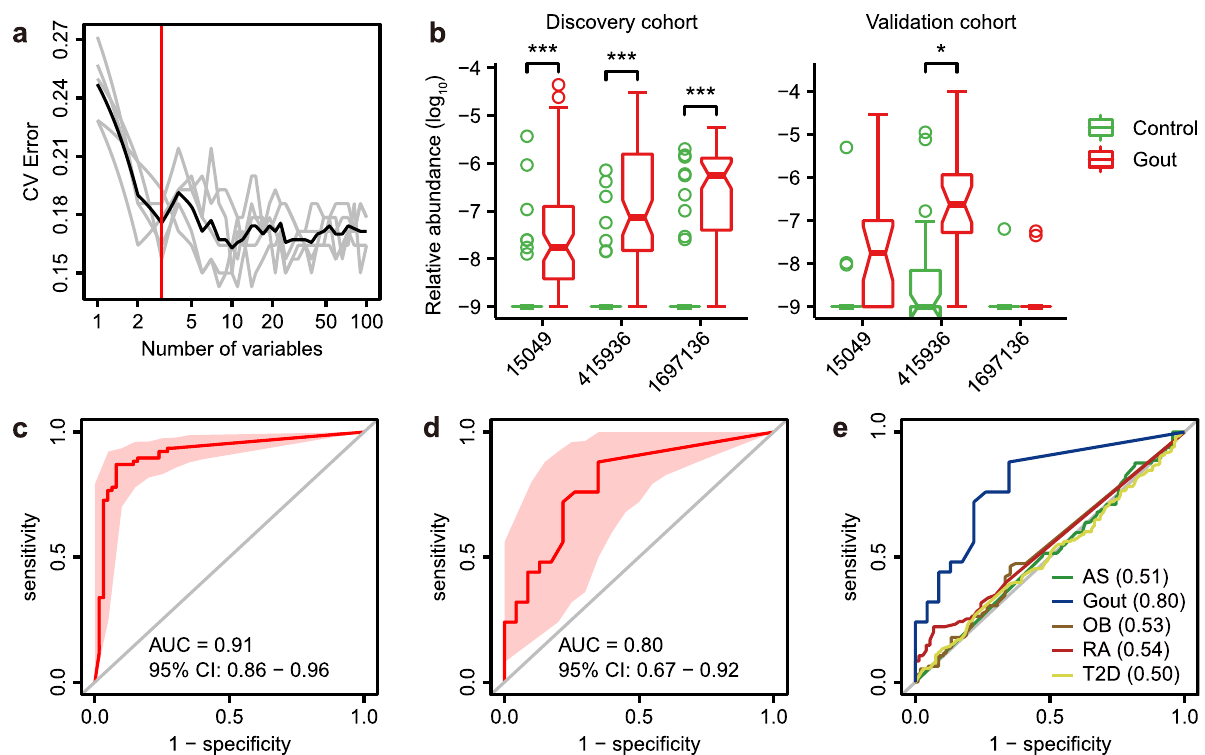
Fig. 4 The gut metagenomic classi fi er for gout. a The model was trained using relative abundance of microbial genes in discovery cohort. All microbial genes were fi rst ranked based on their variable importance and then added sequentially into the model. The error curves were plotted for the fi ve trials of 10-fold cross-validation in random forest classi fi cation as the number of genes increased. The black curve indicates the average cross-validation error of the fi ve trials (in gray). The minimum error in the averaged curve plus the standard deviation at that point was used as the cutoff for feature selection. The model containing the smallest number of genes with an error below that cutoff was chosen as the optimal classi fi er. The red line marks the number of genes in the optimized model. b The relative abundance of three microbial gene markers in discovery and validation cohorts. Wilcoxon rank-sum test: ‘ asterisk ’ denotes FDR P < 0.05; ‘ double asterisks ’ denote FDR P < 0.01; ‘ triple asterisks ’ denote FDR P < 0.001. c Receiver operating curve (ROC) for the discovery samples. d ROC for the validation samples (healthy control, n = 23; gout patient, n = 25). e ROCs for gout and four public case-control metagenomic datasets for ankylosing spondylitis (AS), obesity (OB), rheumatic arthritis (RA), and type 2 diabetes (T2D) using three gout-associated gene markers. The AUC for each disease was shown in parenthesis. For all box and whisker plots, the center line represents median. The bounds of box represent the fi rst and third quartiles. The upper whisker extends from the hinge to the largest value no further than 1.5 * interquartile range (IQR) from the hinge. The lower whisker extends from the hinge to the smallest value at most 1.5 * IQR of the hinge. The notch represents a con fi dence interval around the median as the median ± 1.58*IQR/sqrt( n